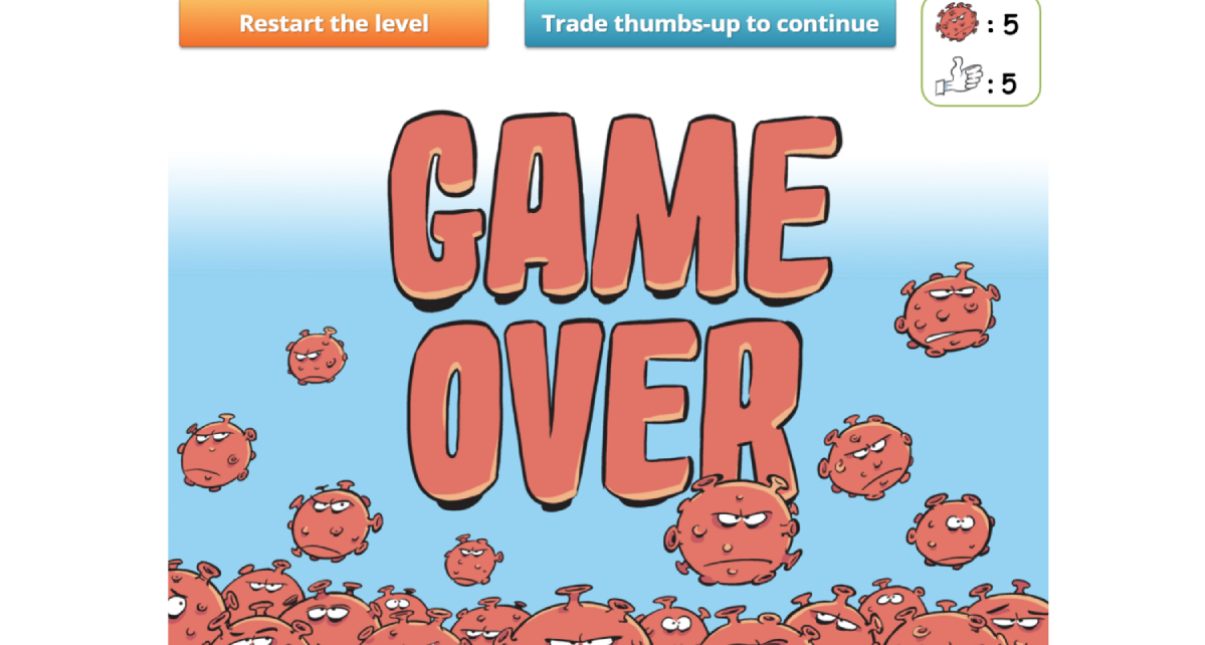
Figure 18. Game over screen. The player can choose to exchange their thumbs-up for viruses (1:1) or to restart the level and decrease the virus count by